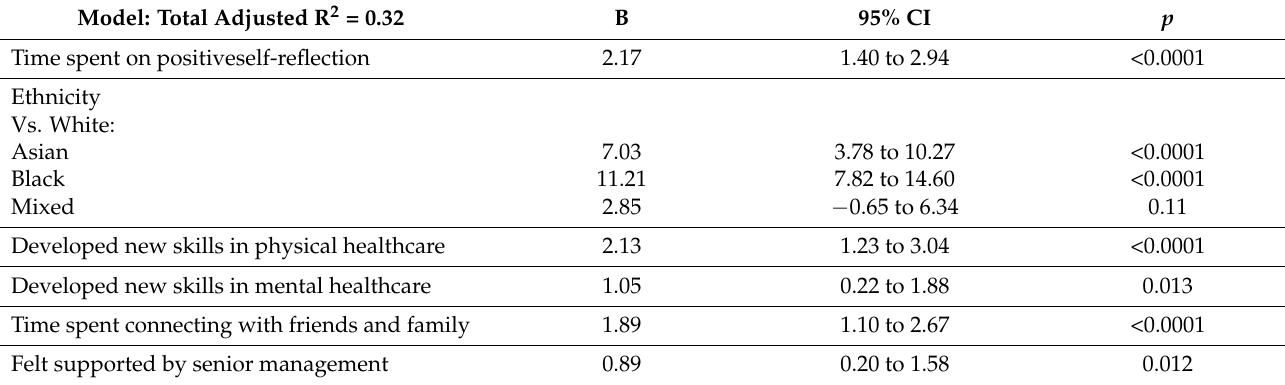
Table 2. Final multiple regression model (Model